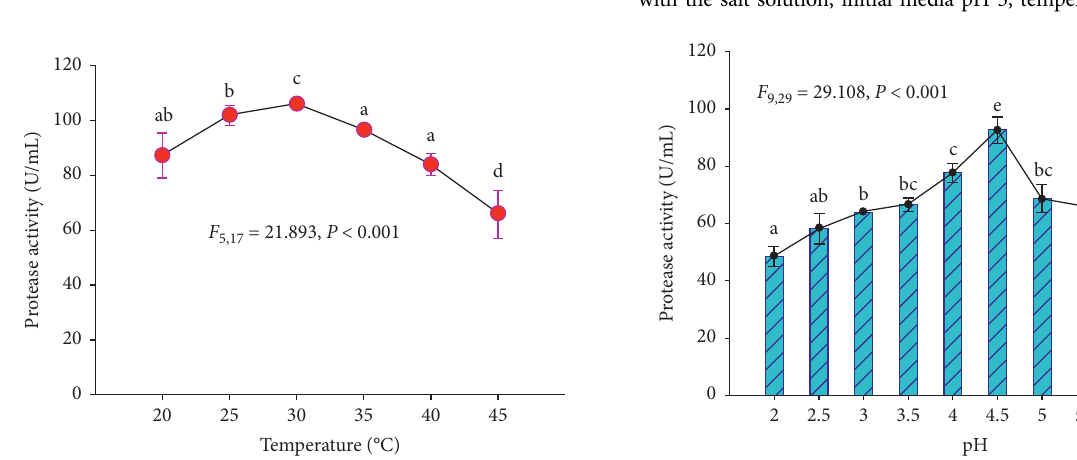
Figure 5: Effect of incubation temperature on acid protease production from the filamentous fungal isolate Z1BL1 in SSF. Different letters (a, b, c, d) designate significantly different means as determined by the SPSS test ( P < 0 . 001 ) ; temperature 30 ° C; initial media pH 4.5.